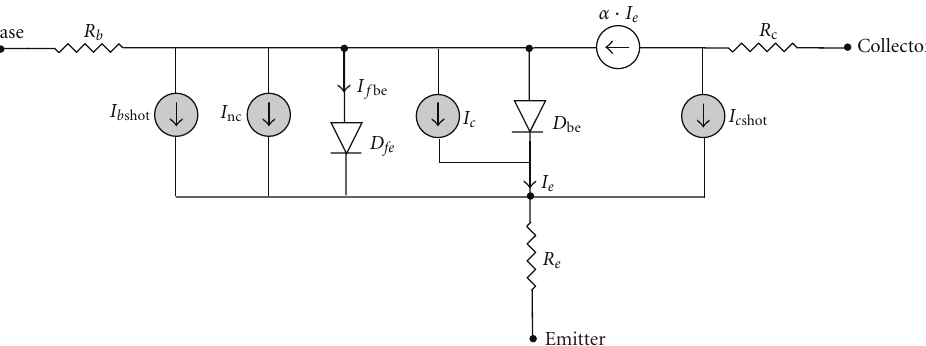
Figure 6: LF equivalent circuit of the transistor with noise sources.